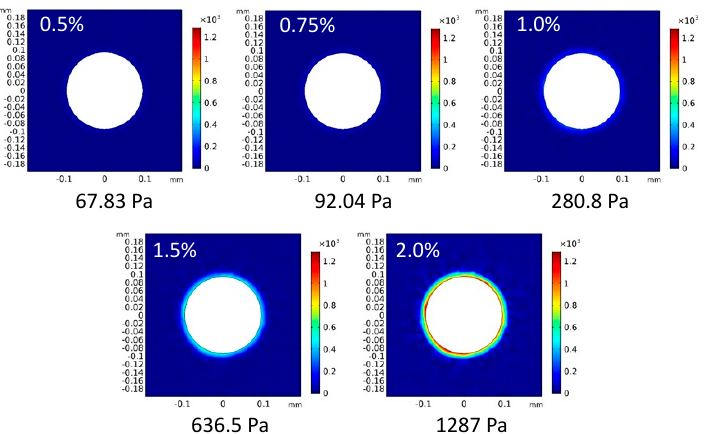
Figure 9. Solid stress distribution and maximum values of von Mises stress in the numerical analysis model.